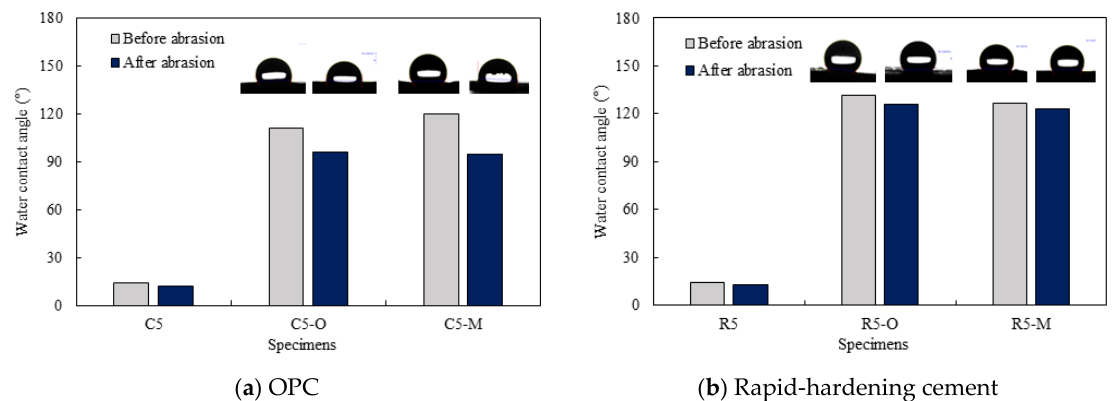
Figure 5. Water contact angle and water droplet shape of cement mortar mixed with water repellents.